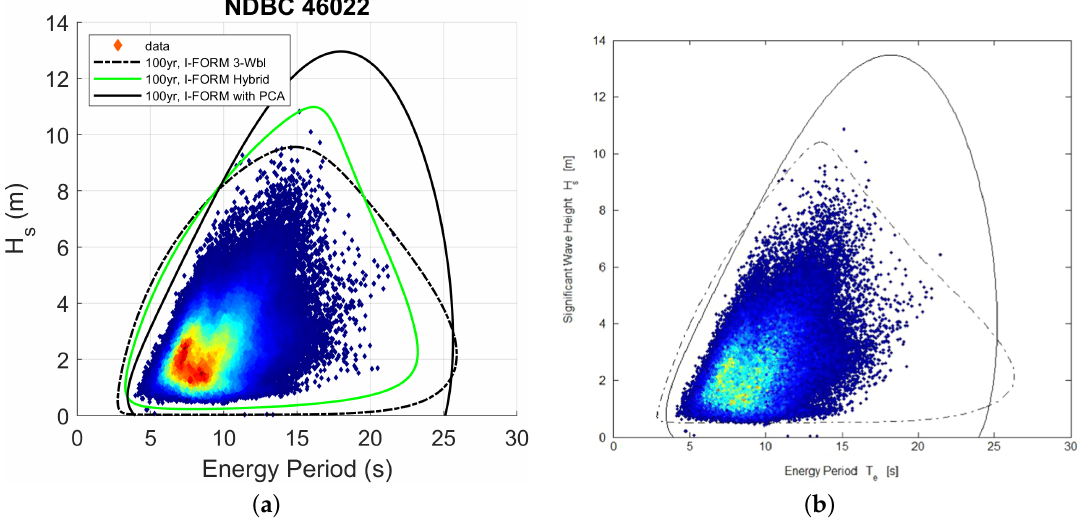
Figure 7. In subfigure ( a ) data from NDBC 46022 [61] are used to obtain contours to be compared with Figure 11b in Eckert-Gallup et al. [27], here reprinted in subfigure ( b ) with permission from Elsevier, Copyright 2016. In the two plots, the black solid lines show the I-FORM with PCA, and the black dashed lines show the I-FORM with 3-parameter Weibull fit for H s . Note that the data density coloring scheme differ slightly for the two plots and thus no comparison regarding data density can be made.